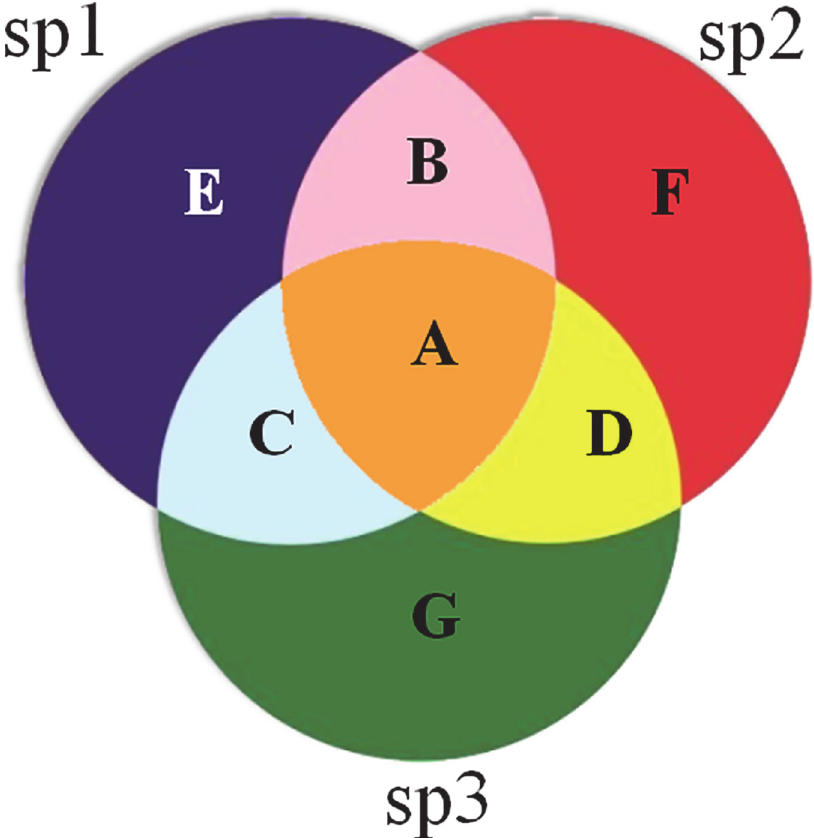
Fig 3. Comparison of SNPs from three different IFV subpopulations. Area A contains universal SNPs. Areas B, C and D consist of likely common SNPs. Areas E, F and G contain unique SNPs.